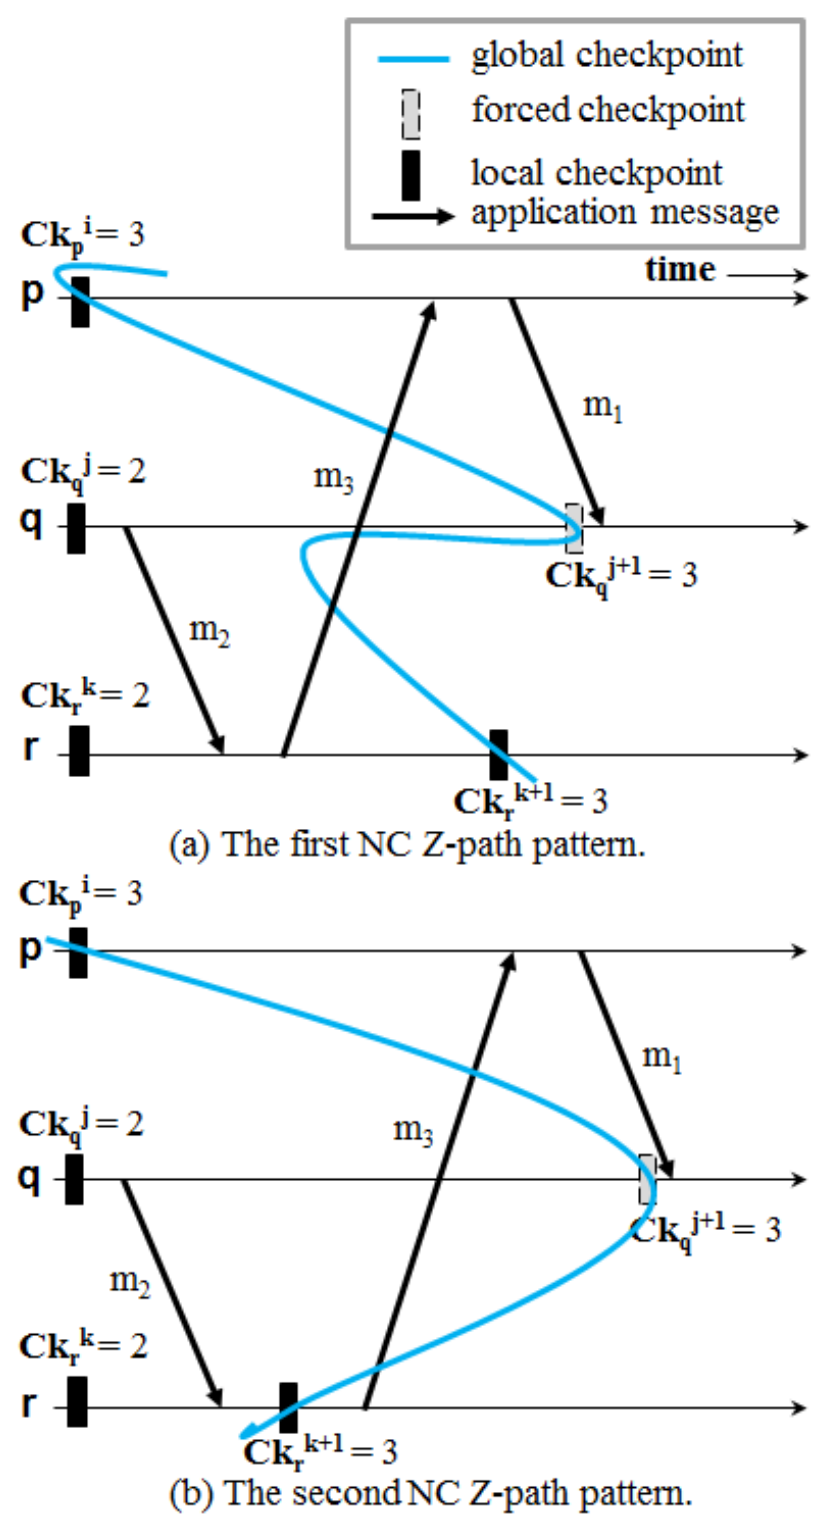
Figure 1. Preventing uselessness of local checkpoints in